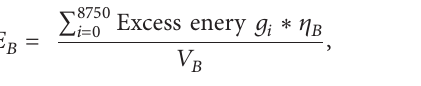
where 𝜂 𝐵 and 𝑉 𝐵 are the charging efficiency and the battery voltage, respectively.